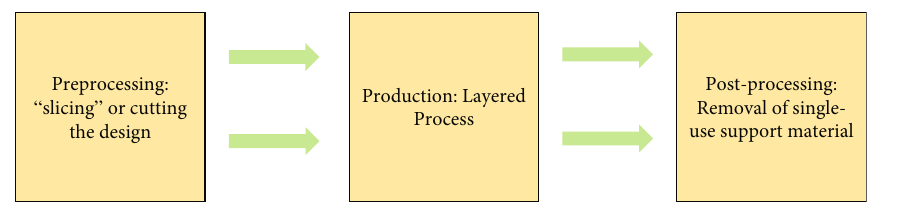
Figure 1: Working principle fl ow